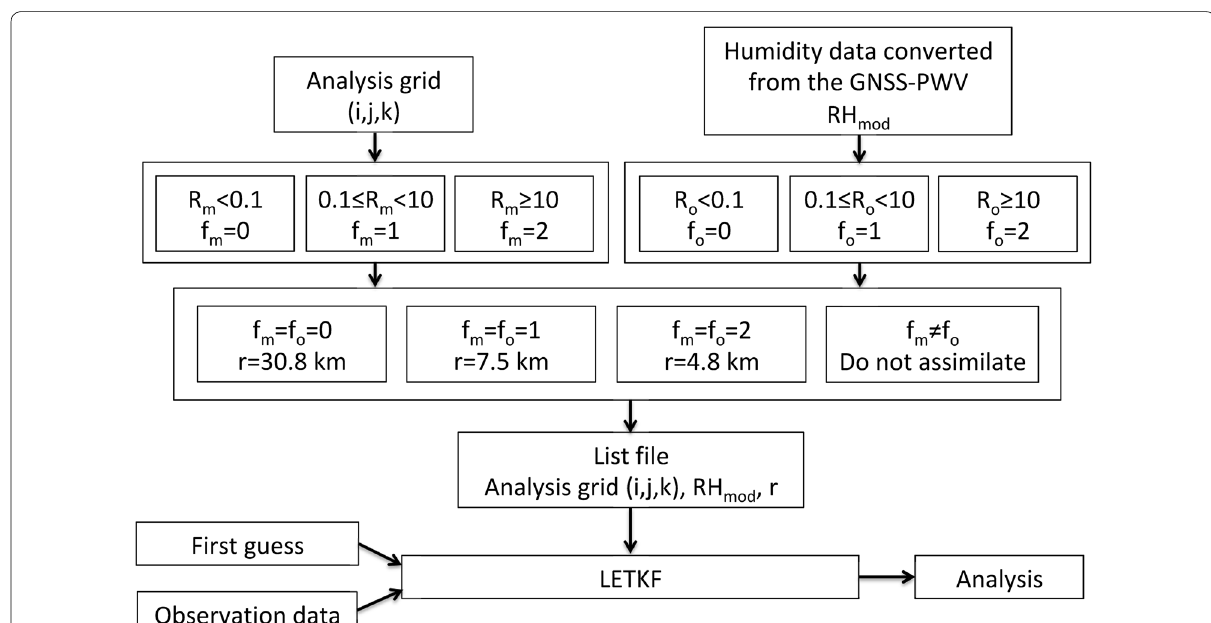
Fig. 8 Flowchart illustrating how the localization radii in the SLOC experiment were determined. R m and R o indicate precipitation intensity observed by weather radar at the analysis grid point, and the GNSS station, respectively. The character “ r ” indicates the localization radius needed to assimilate RH mod data converted from the GNSS-derived